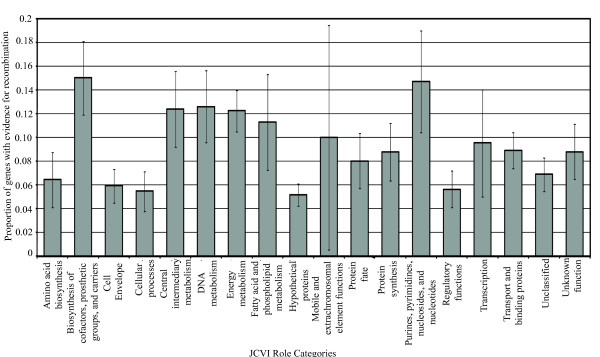
Proportions of genes with evidence of recombination among individual JCVI role categories. Genes with evidence for recombination (Q < 0.1) in at least one of the four tests were included. Bars indicate estimated standard error for the proportion of genes with evidence of recombination in each role category; standard errors were calculated as square root of p (1-p)/n, where p is the proportion of genes with evidence of positive selection in a given role category, and n is the total number of genes in a given role category. Among the 20 JCVI role categories, two did not include genes with evidence of recombination (i.e., "Signal Transduction" and "Viral functions") and are thus not included in this figure.